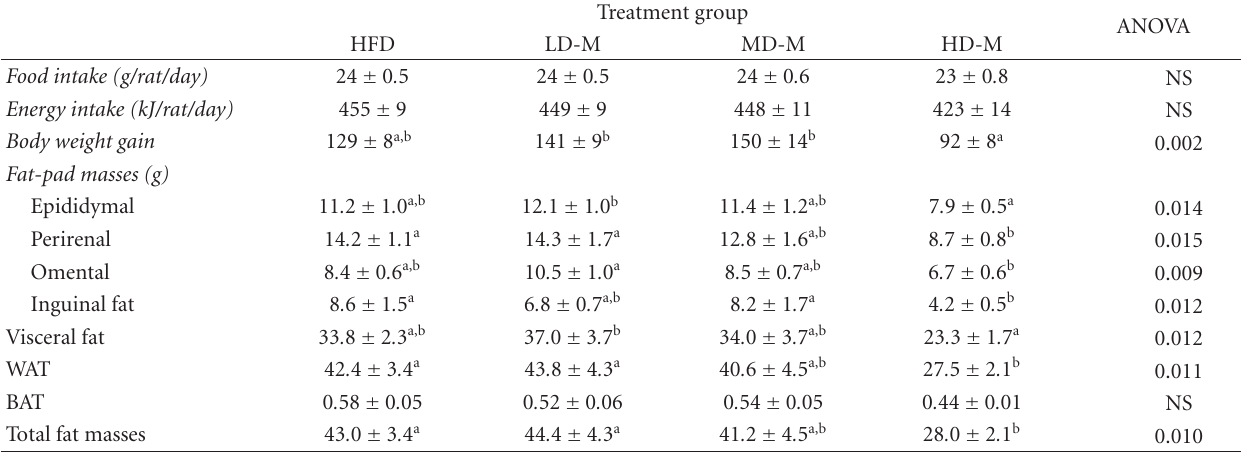
Table 2: Food intake, energy intake, body weight, and fat deposits of rats fed experimental diets for 6 weeks 1